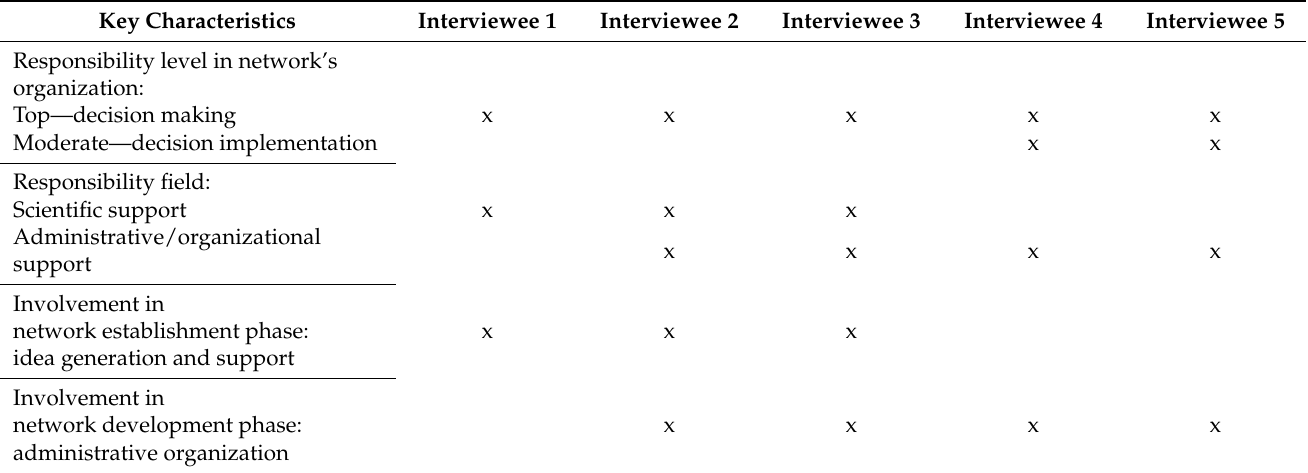
Table 1. Summary of complementary interviewees’